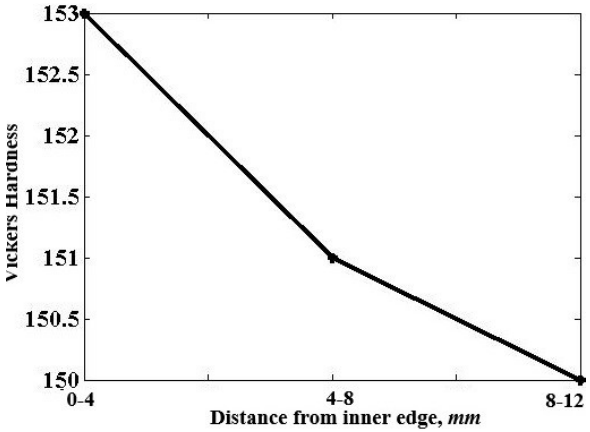
Figure 6: Variation of Vickers hardness values along radial direction for Al-Al 2 Cu thick FGM cylindrical shell